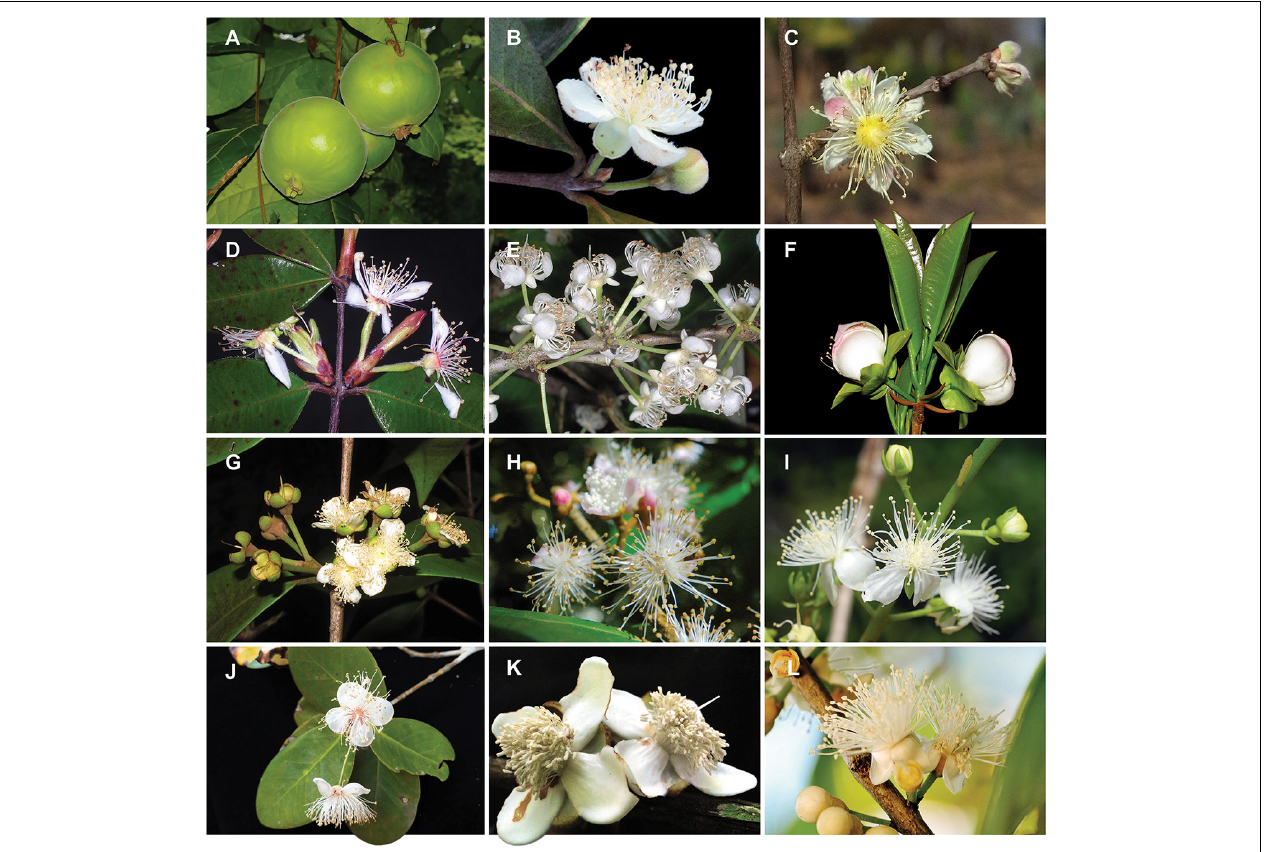
FIGURE 1 | Diversity of infrageneric groups of Eugenia. (A) E. stipitata – sect. Pilothecium. (B) E. klotzschiana – sect. Pseudeugenia. (C) E. myrcianthes – sect. Hexachlamys. (D) E. neosilvestris – sect. Eugenia. (E) E. excelsa – sect. Excelsae. (F) E. involucrata – sect. Phyllocalyx. (G) E. acutata – sect. Schizocalomyrtus. (H) E. disperma – sect. Racemosae. (I) E. bunchosiifolia – sect. Speciosae. (J) E. reinwardtiana – sect. Jossinia. (K) E. abunan – sect. Umbellatae. (L) E. pluriflora – sect. Umbellatae. Size of reproductive organs varies between c. 1 and 7 cm. Pictures by A. Giaretta (A,D,E–G) , K. Valdemarin (B) , P. Gaem (C) , A. Maruyama (H) ,